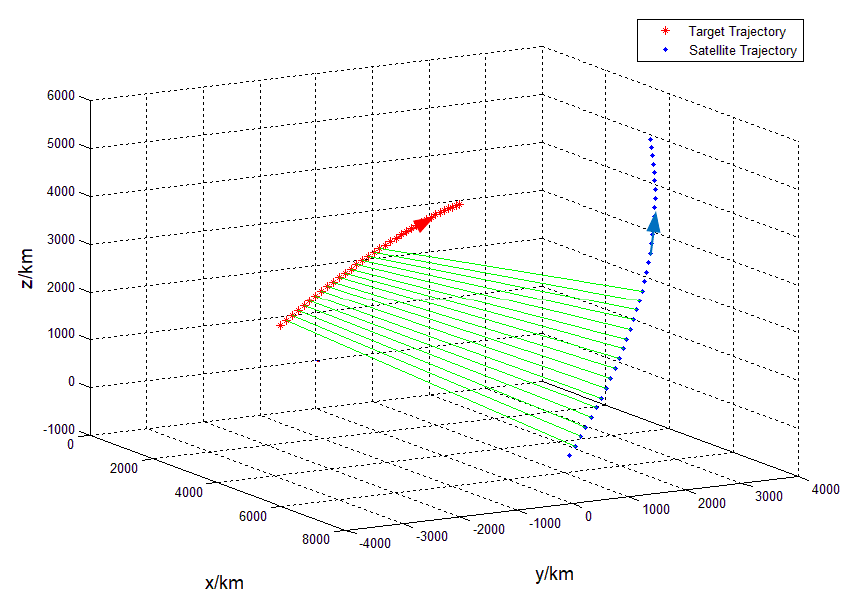
Figure 6. Trajectory of satellite and target with access link.